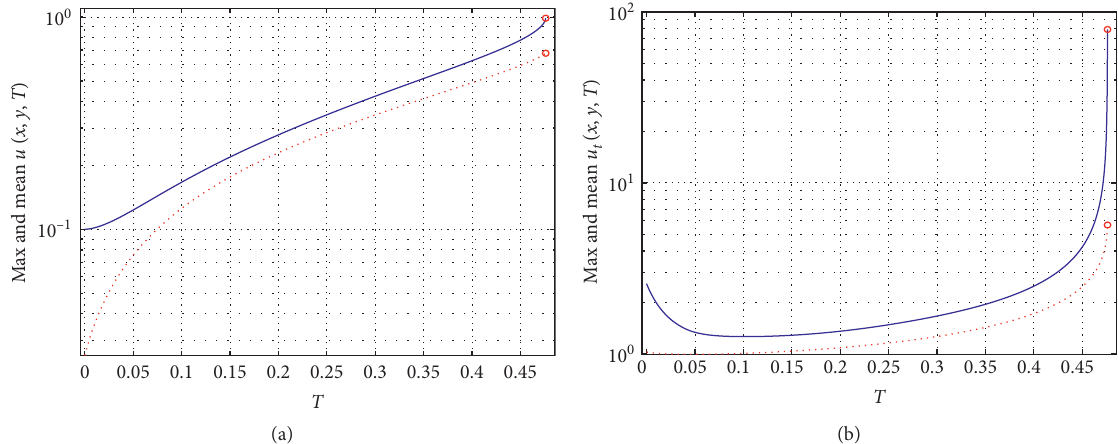
Figure 3: Trajectories of the maximal (blue curves), mean values (red dotted curves) of u ( x,y, T ) , 0 ≤ x, y ≤ 1, (a); and the maximal (blue curves), mean values (red dotted curves) of u t ( x, y,T ) , 0 ≤ x,y ≤ 1, (b) for T ∈ ( 0 , 69725 τ ] . Explosive increments of the maximal derivative function values as t approaches the quenching time 68725 τ ≈ 0 . 47623113 < T ∗ ≈ 69727 τ ≈ 0 . 47624479 are again visible. This is consistent with quenching criteria (6) and